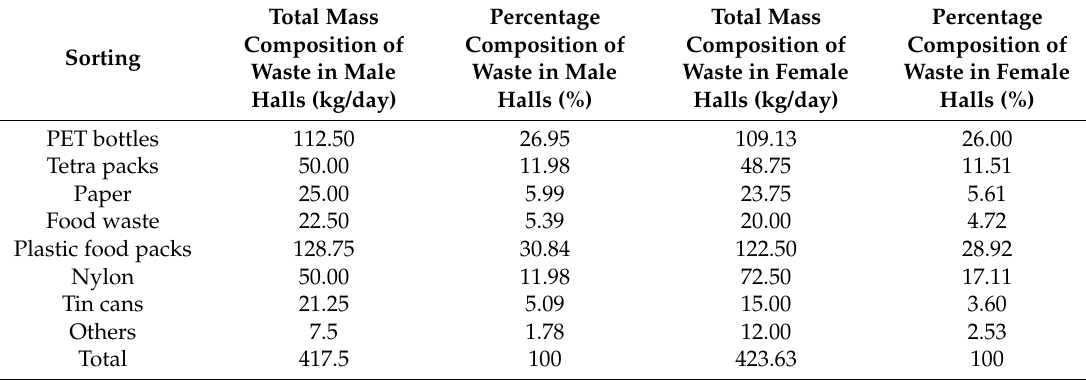
Table 4. Material comparison of waste generated in the students’ hall of